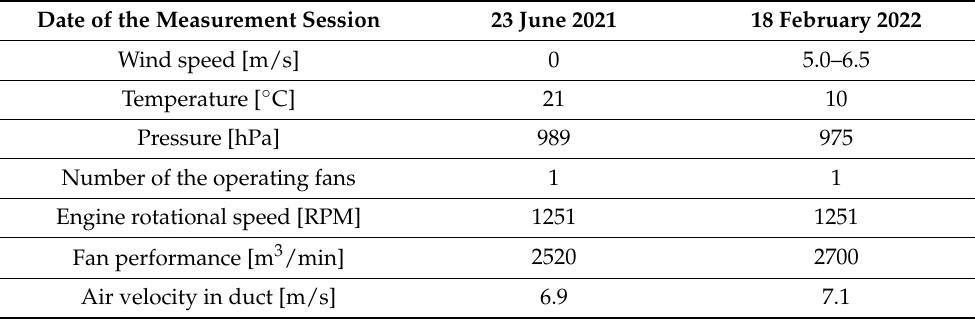
Table 2. Operating parameters of the Ko´sciuszko ventilation shaft system during measurement